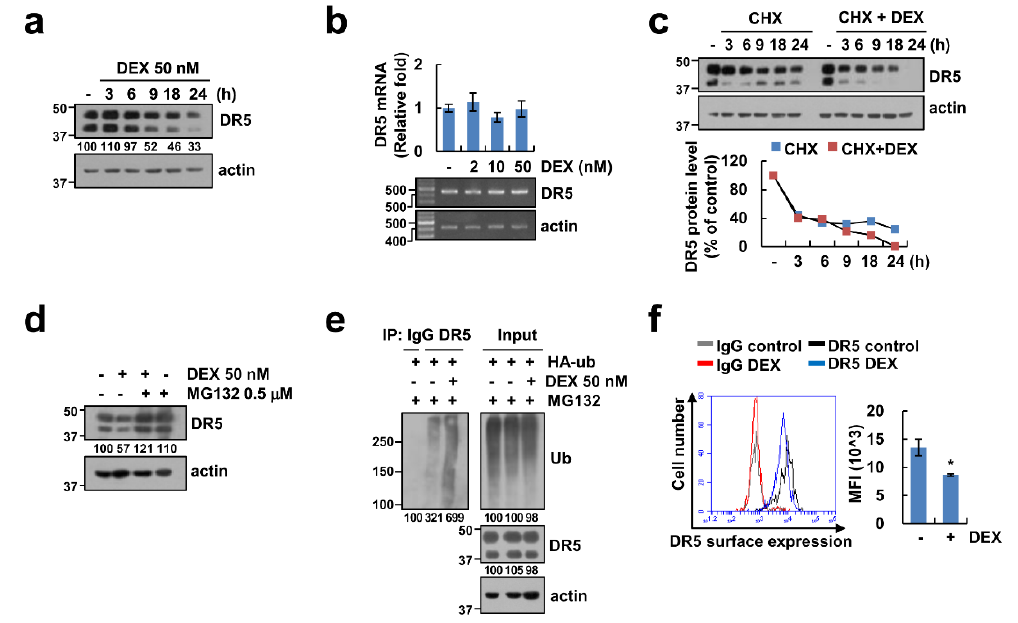
Figure 5. DEX reduces DR5 protein stability. ( a , b ) Caki-1 cells were treated with 50 nM DEX for the indicated time periods ( a ) or indicated concentrations of DEX for 24 h ( b ). ( c ) Cells were treated with 20 µ g / mL cycloheximide (CHX), in presence or absence of 50 nM DEX for the indicated time points. Band intensity of DR5 was analyzed using ImageJ. ( d ) Caki-1 cells were pretreated with 0.5 µ M MG132, and then treated with 50 nM DEX for 24 h. ( e ) DR5 ubiquitination was detected by Western blotting. ( f ) Caki-1 cells were treated with 50 nM DEX for 24 h and measured DR5 expression on the cell surface. Protein and mRNA levels were analyzed by Western blotting ( a , c – e ) and RT-PCR or qPCR ( b ), respectively. Values in the graphs ( b , f ) represent mean ± SD of three independent experiments. * * p < 0.01 compared to control. Uncropped pictures of the western blot shown in the Supplementary Figure 7.